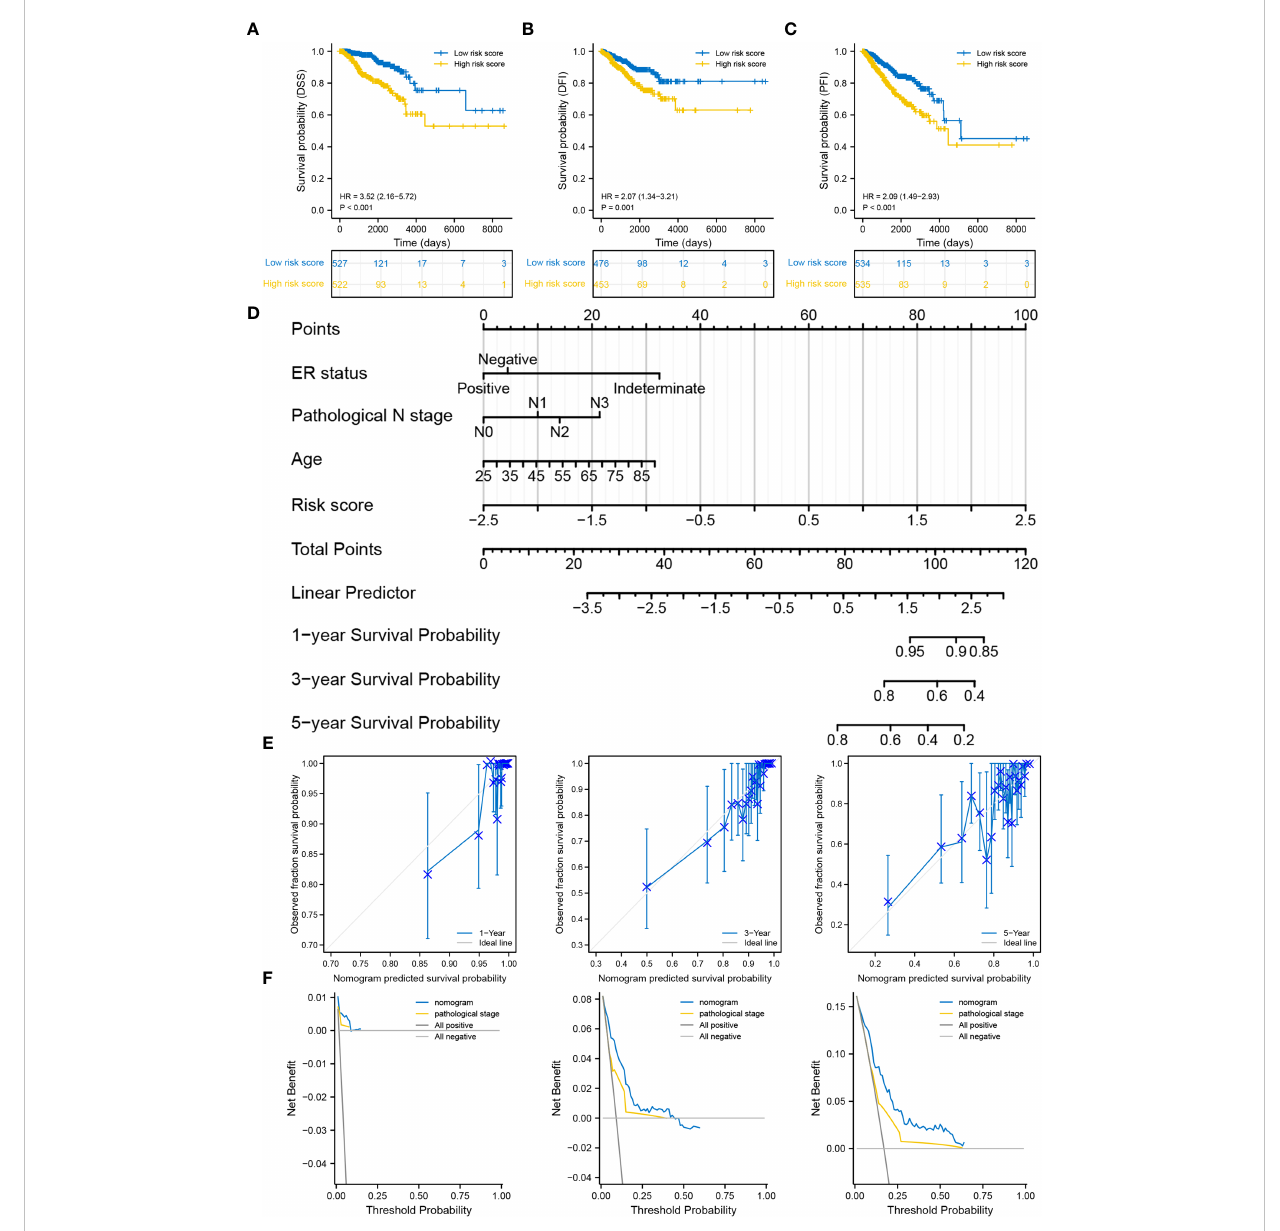
FIGURE 5 Correlation between the degradome signature and clinicopathological characteristics. (A – C) Survival differences in DSS, DFI and PFI between the low- and high-risk groups. (D) Prognostic nomogram based on clinicopathological characteristics and risk score. (E) Calibration curves of the nomogram at 1-, 3- and 5-year. (F) DCA of the nomogram at 1-, 3- and